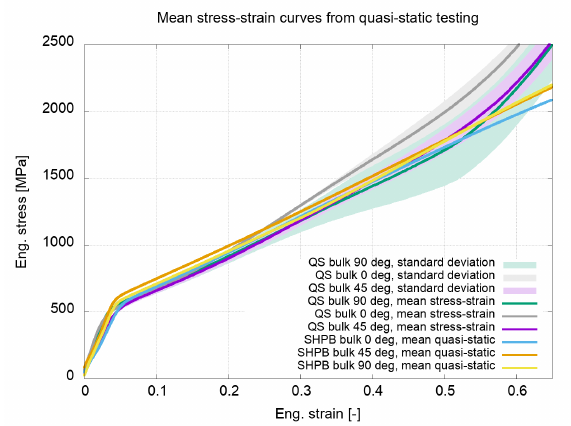
Figure 5. Mean stress-strain curves evaluated from quasi-static experiments